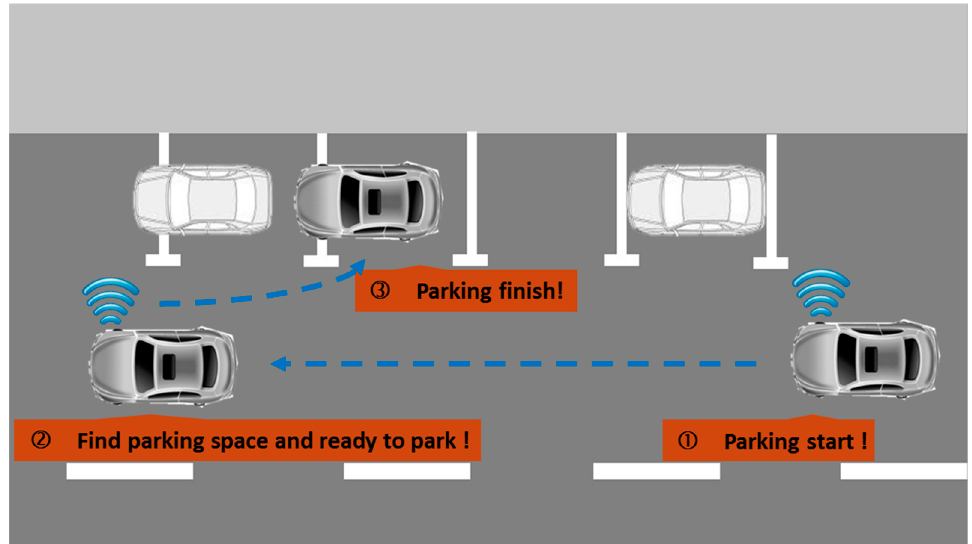
Figure 1. Scenario involving currently available automated parking systems .